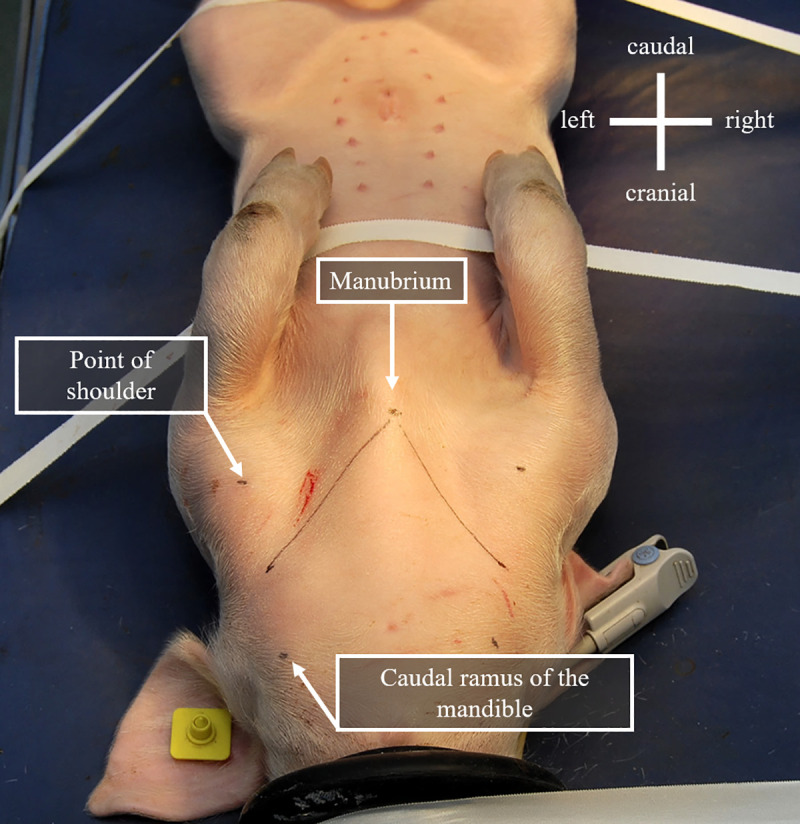
Landmarks for the determination of the expected passage of the external jugular vein in 21 days old piglet.